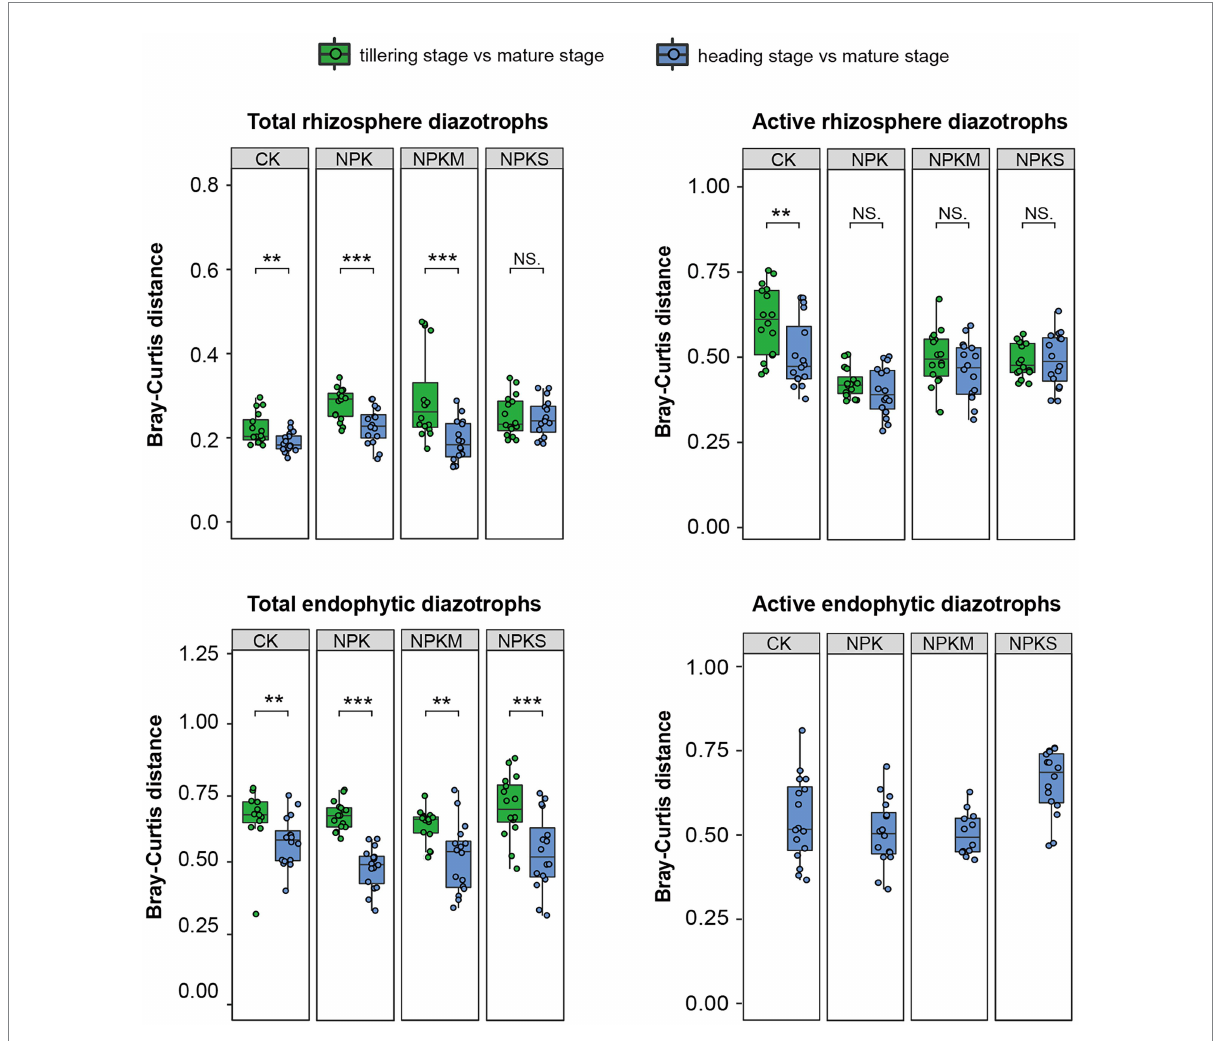
FIGURE 4 Bray–Curtis distances between the diazotrophic communities of samples collected at the mature stage and samples collected at the other growth periods in each microhabitat at the DNA and RNA levels in 2016. Significance level: p ≥ 0.05, ns; p < 0.05, * p < 0.01, ** p < 0.001, ***(Student’s t -test or Wilcoxon’s rank-sum